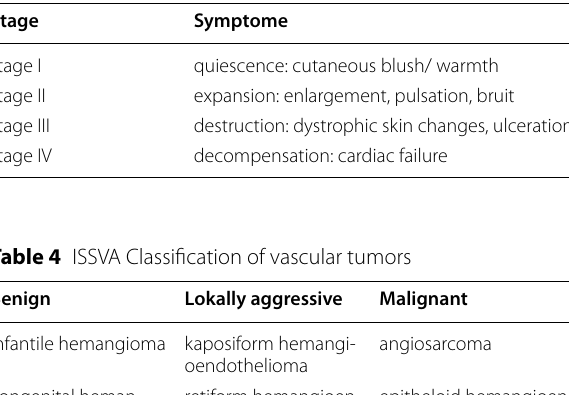
Table 3 Schobinger staging system for AVMs